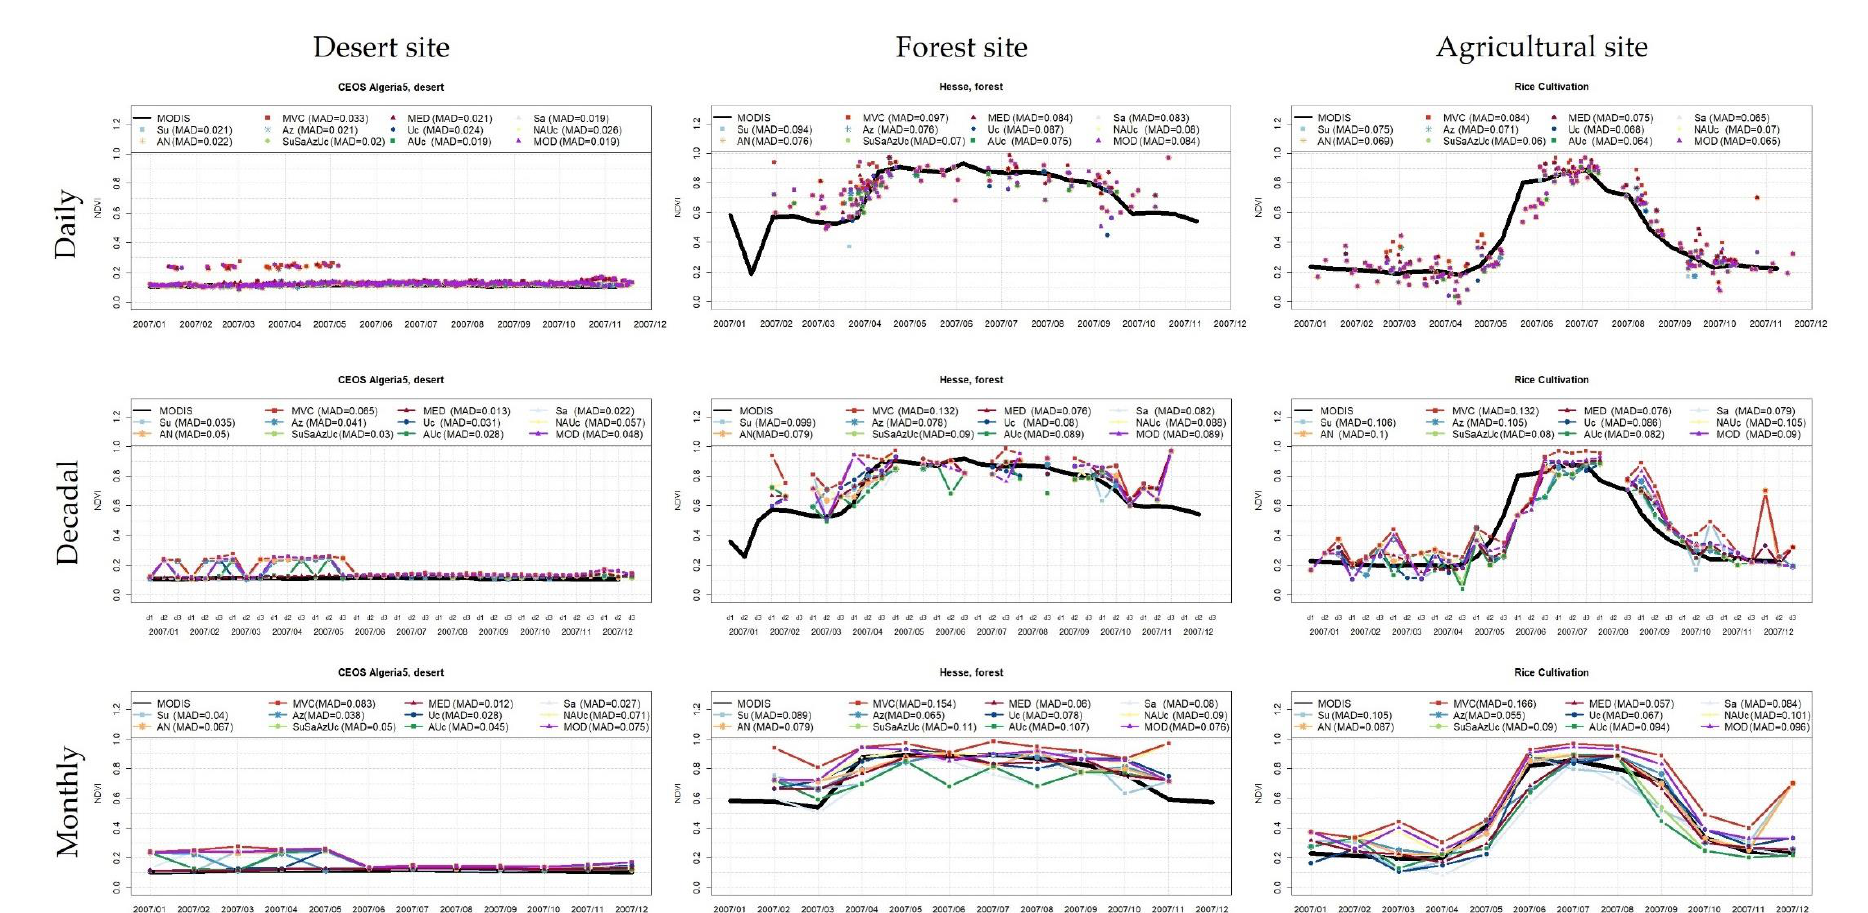
Figure 8. Time series of daily ( top ), decadal ( middle ), and monthly ( bottom ) NDVI at the Algeria 5 (exemplary desert site), Hesse (exemplary forest site), and Piedmont (exemplary agriculture site) stations. In black, the MOD13A2 (16 days interpolated to decadal and daily intervals, respectively, top and middle ) and MOD13A3 (monthly, bottom ) are plotted as references. For better visualization, graphs are split up, showing the “single variable composites” (MVC, MED, Sa, Su, Az, and Uc) and the “multiple variable composites” (NAUc, AN, SuSaAzUc, AUc, and MOD) separately in Figure S6.